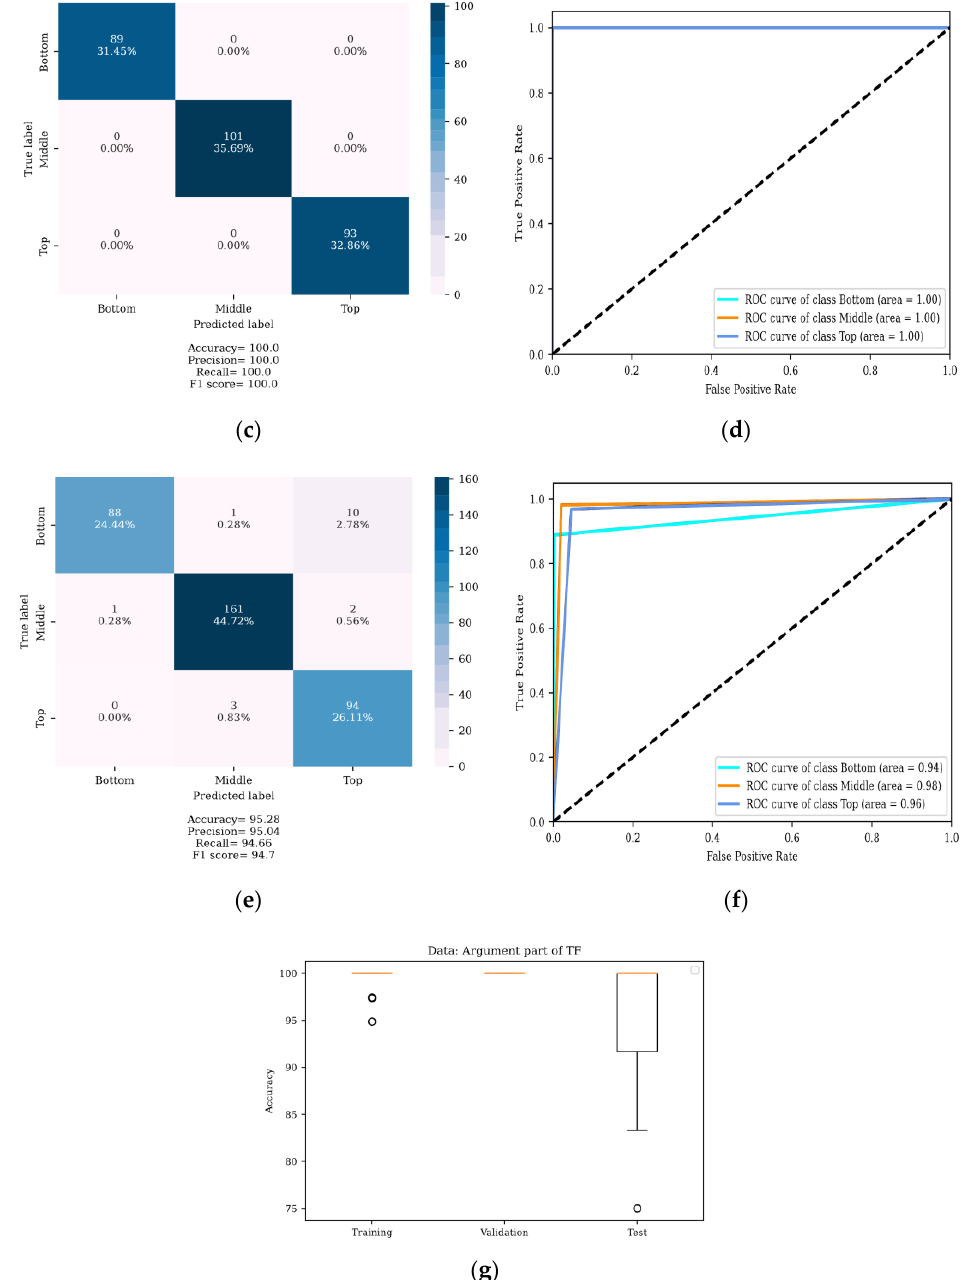
Figure 24. GMDH performance in localization of the DSV fault using data of phase part of the TF: ( a ) training confusion matrix; ( b ) training ROC curve; ( c ) validation confusion matrix; ( d ) validation ROC curve; ( e ) test confusion matrix; ( f ) test ROC curve; ( g ) box plot of the training, validation, and test accuracies in thirty iterations.